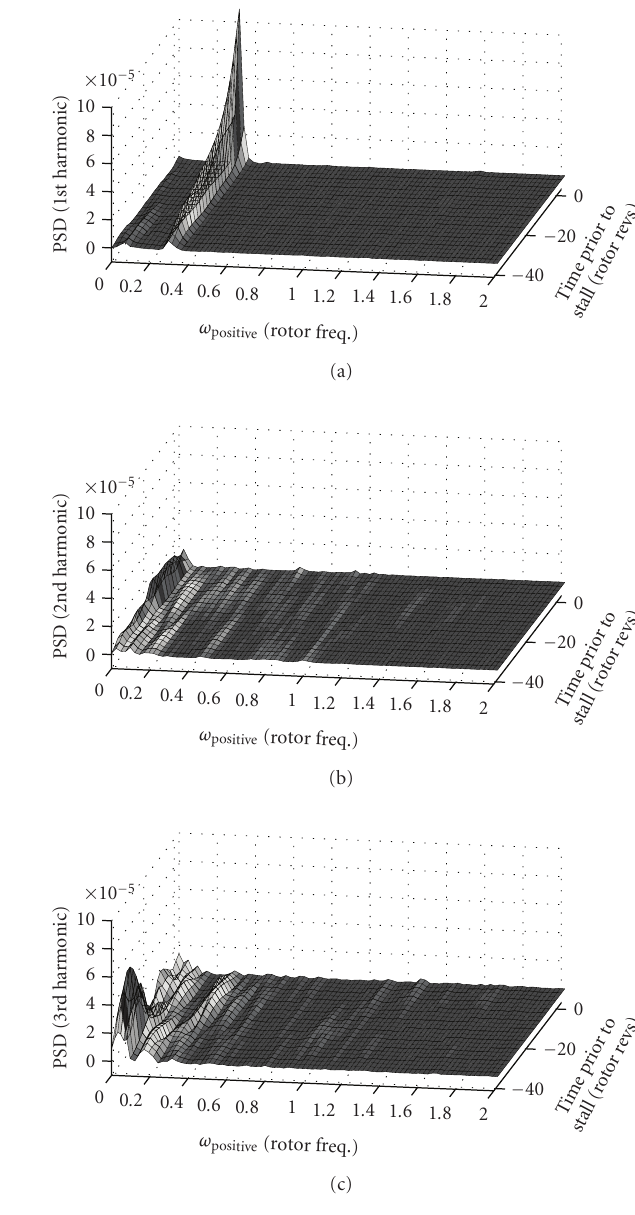
Figure 17: PSD of first three spatial harmonics of measured prestall disturbance with mean blowing and no control (positive rotating